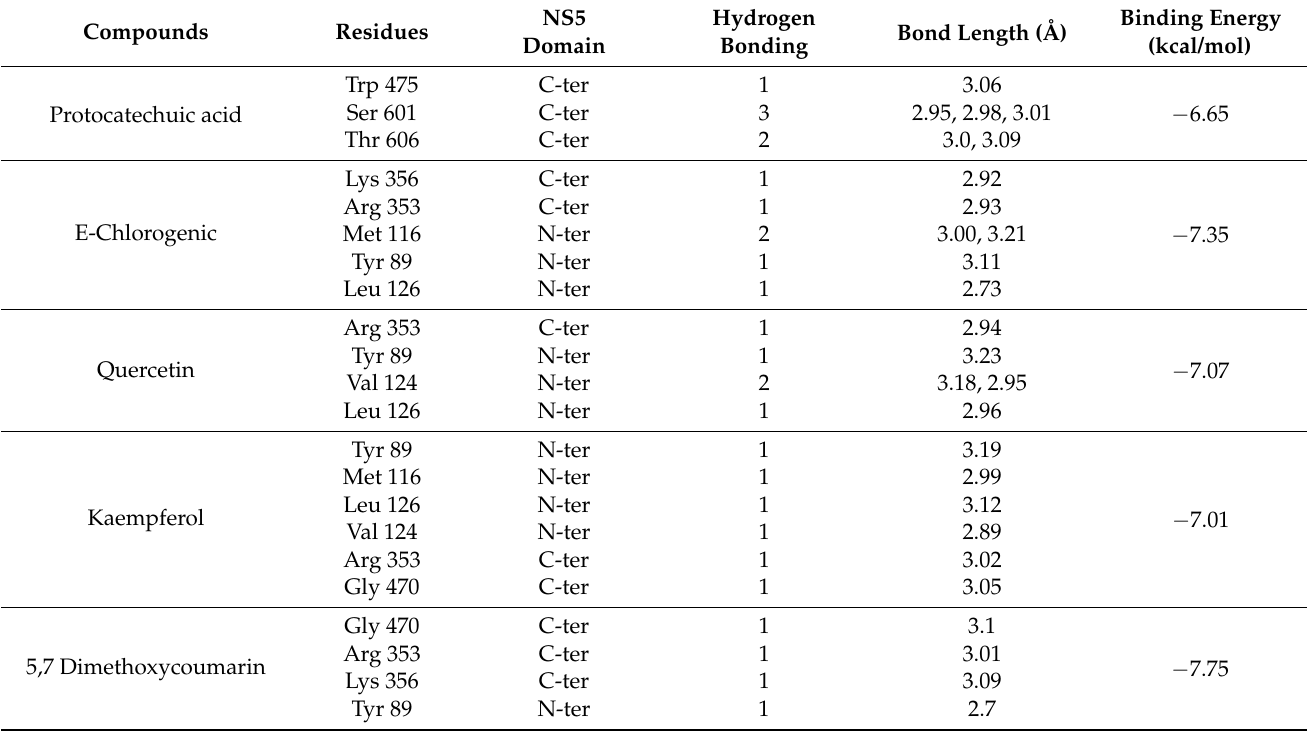
Table 2. Binding interactions of DENV-2 NS5 with specific bioactive compounds of C. papaya leaf extracts. Compounds